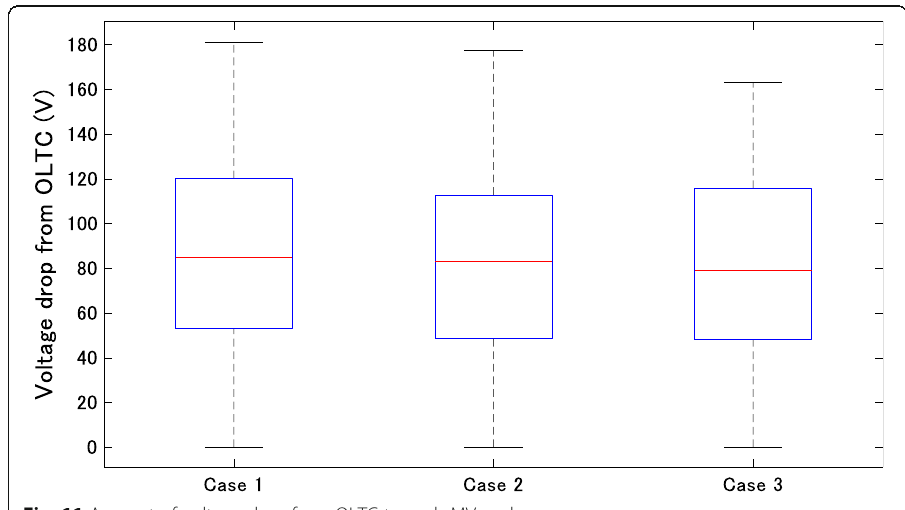
Fig. 11 Amount of voltage drop from OLTC to each MV